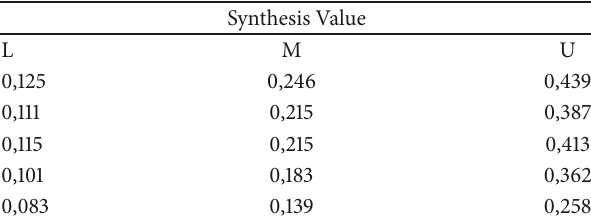
Table 7: Synthesis value.